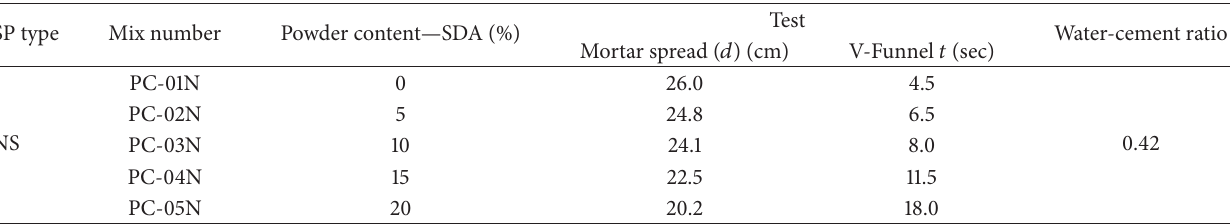
Table 5: Powder content